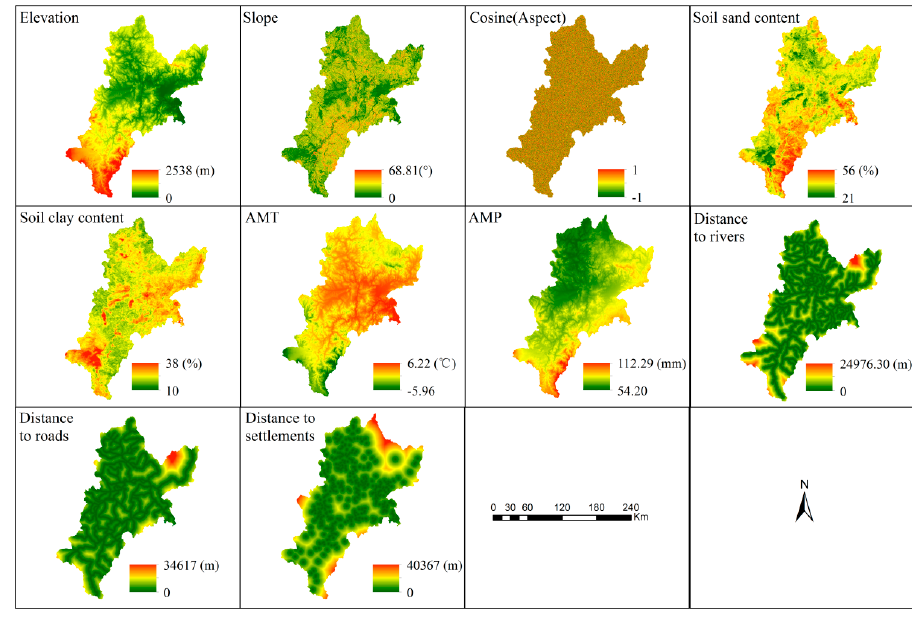
Figure 3. Potential 2010 factors considered for the study area.